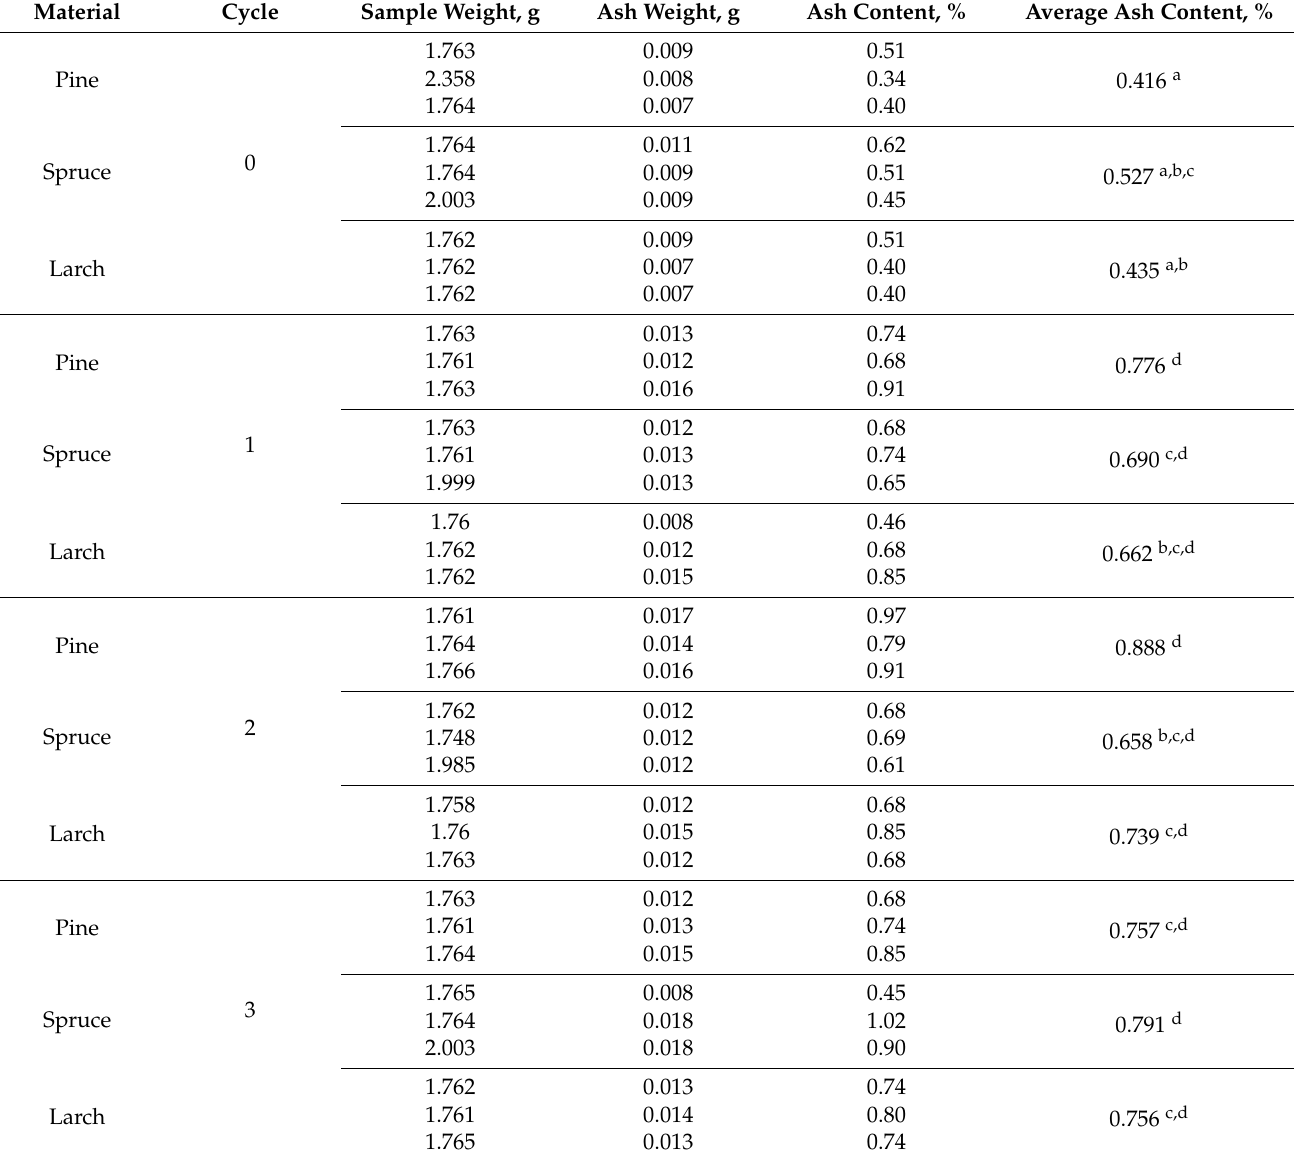
Table 5. Breakdown of the percentage share of